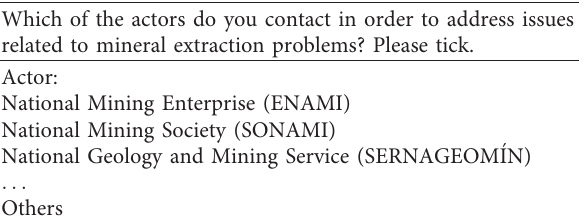
Table 3: Example of the questionnaire for stakeholders. Which of the actors do you contact in order to address issues related to mineral extraction problems? Please